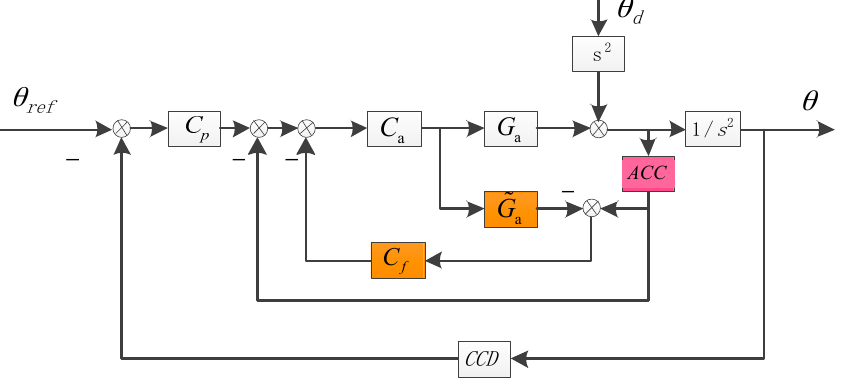
Figure 3. The structure of the ADLC with DOB. (cid:101) G a is the approximate acceleration model of the FTOS. C f is the DOB FTOS.